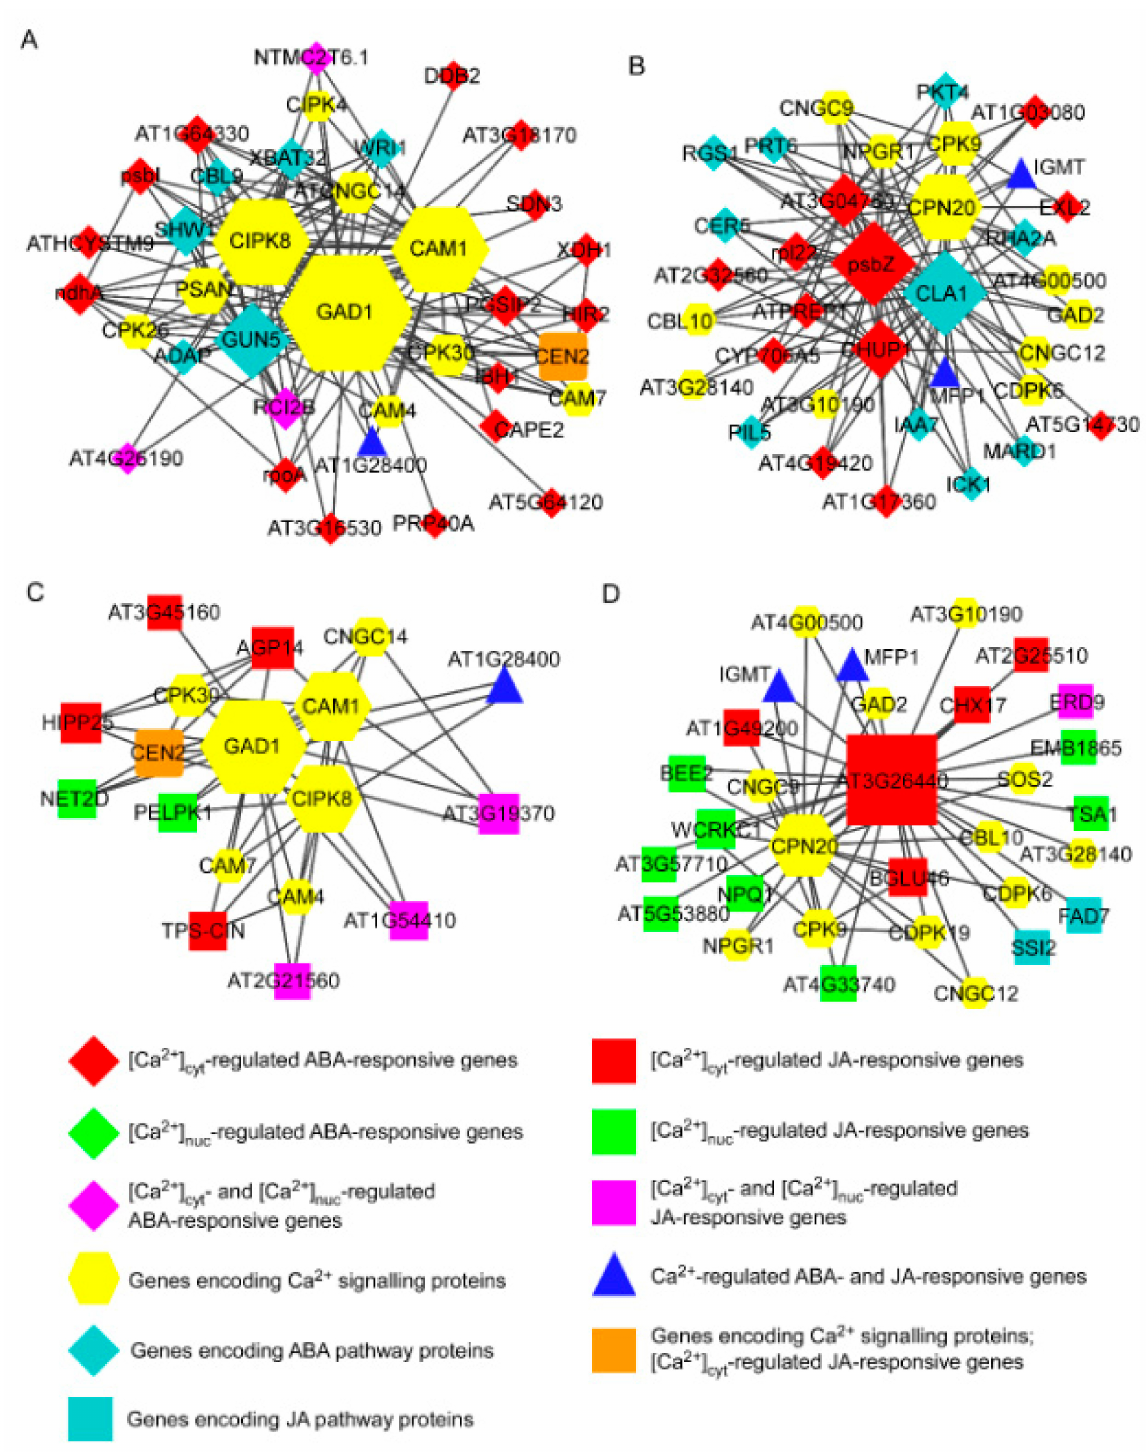
Figure 3. Calcium-mediated phytohormone-associated gene co-expression networks. ( A , B ) Sub- models with distinct central genes and their co-expression partners among [Ca 2+ ] cyt - and [Ca 2+ ] nuc - regulated ABA-responsive genes, genes encoding calcium signalling proteins, and genes encoding ABA pathway proteins. ( C , D ) Sub-models with distinct central genes and their co-expression partners among [Ca 2+ ] cyt - and [Ca 2+ ] nuc -regulated MeJA-responsive genes, genes encoding calcium signalling proteins, and genes encoding JA pathway proteins. Different colours and shapes indicate distinct types of proteins. Different genes in the models are listed in Table